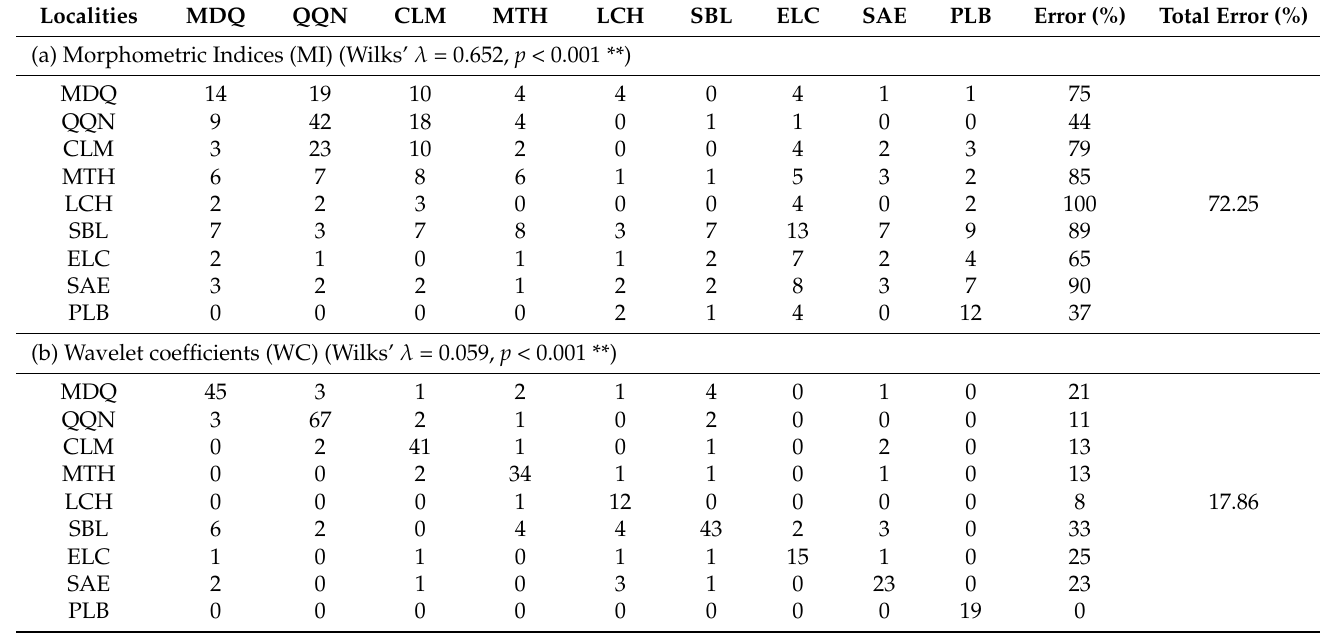
Table 3. Cross-classification table of Linear Discriminant Analysis. MDQ: Mar del Plata; QQN: Quequ é n; CLM: Claromec ó ; MTH: Monte Hermoso; LCH: La Chiquita; SBL: San Blas; ELC: